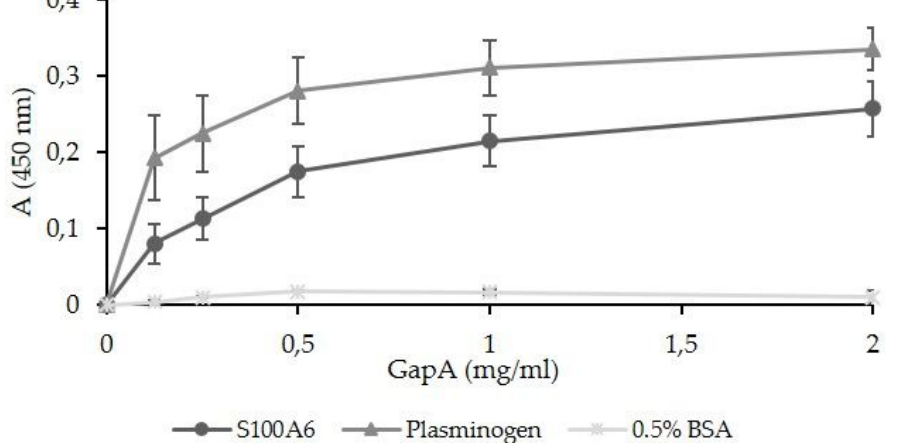
Figure 6. Solid-phase binding assay used for the validation of F. tularensis GapA binding ability to S100A6. The recombinant mouse S100A6 (MyBioSource) plasminogen for positive control and bovine serum albumin as negative control were coated on 96-well microtiter plates and reacted with different concentrations of purified GapA. Data are presented as means ± SD from three independent experiments.